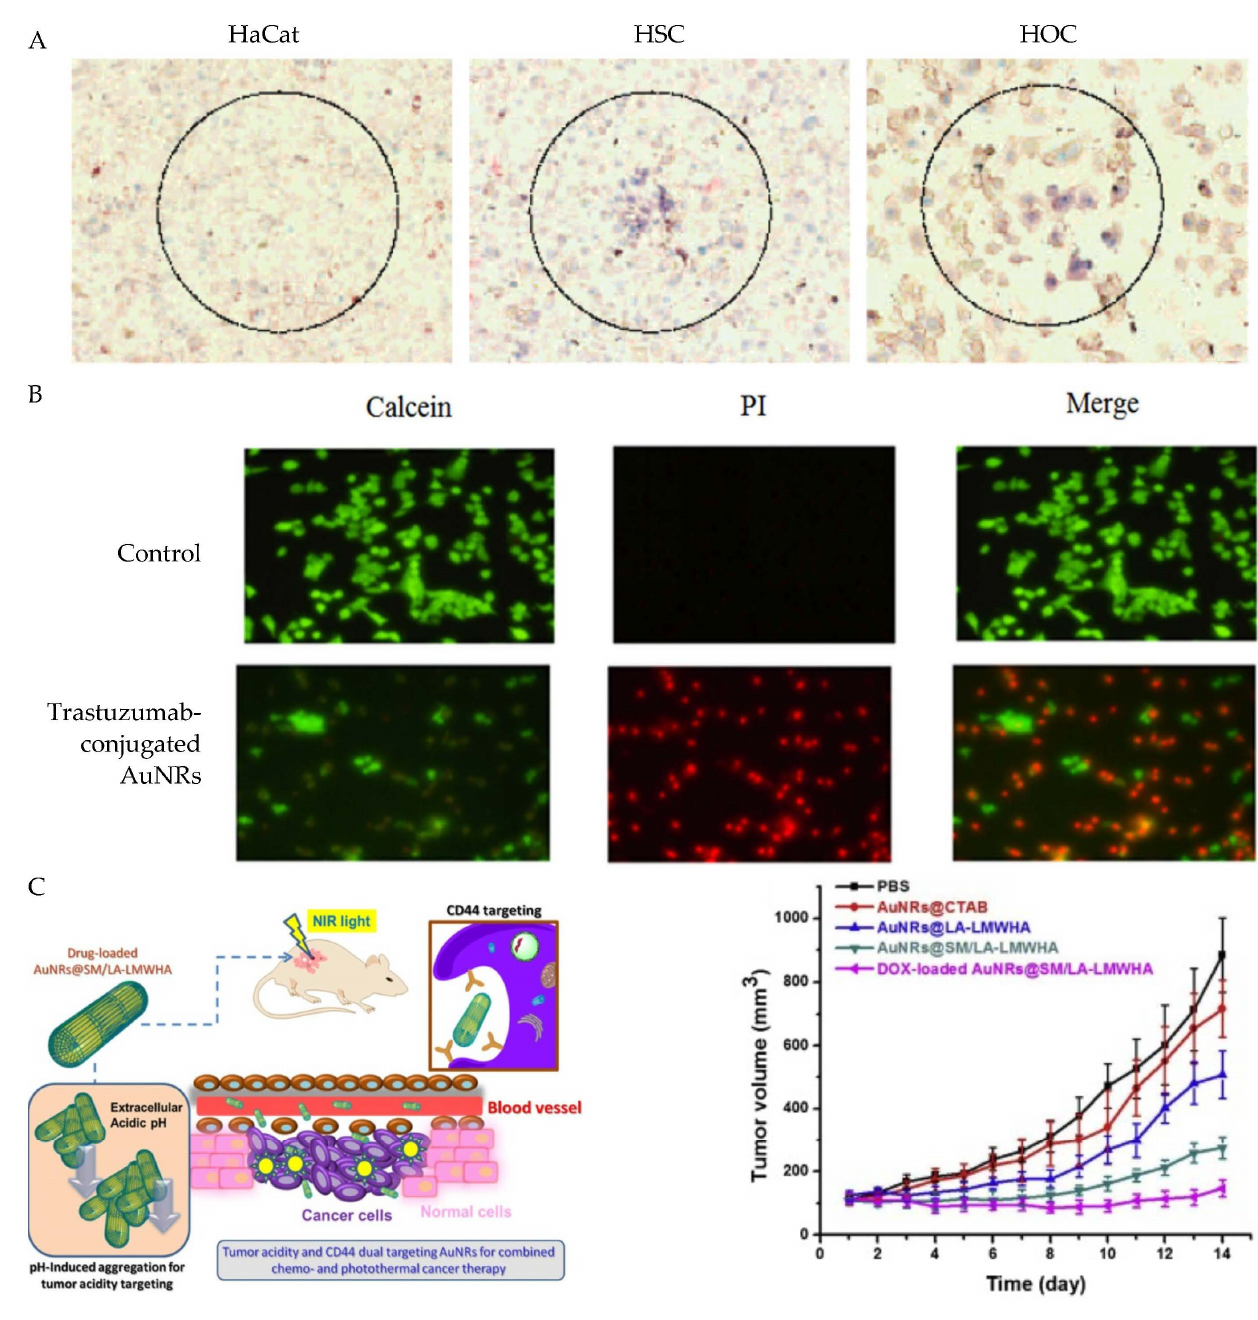
Figure 3. PPTT using ligand-conjugated AuNRs. ( A ) Selective PPTT of HSC ( middle ) and HOC ( right ) head and neck cancer cells over HaCat healthy cells ( left ) using anti-EGFR conjugated AuNRs. Reprinted/adapted with permission from Ref [82]. Copyright © 2010, American Chemical Society. ( B ) PPTT of BT474 breast cancer cells with trastuzumab-conjugated AuNRs. Reprinted/adapted with permission from Ref [85]. Copyright © 2017, Kang, X.; Guo, X.; An, W.; Niu, X.; Li, S.; Liu, Z.; Yang, Y.; Wang, N.; Jiang, Q.; Yan, C.; et al. ( C ) PPTT of MDA-MB-231 xenograft tumors with tumor acidity and CD44 dual targeting hyaluronic acid-coated AuNRs. ( Left ) Sche- matic of the targeting mechanism. ( Right ) Tumor volume at different days of post-treatment with